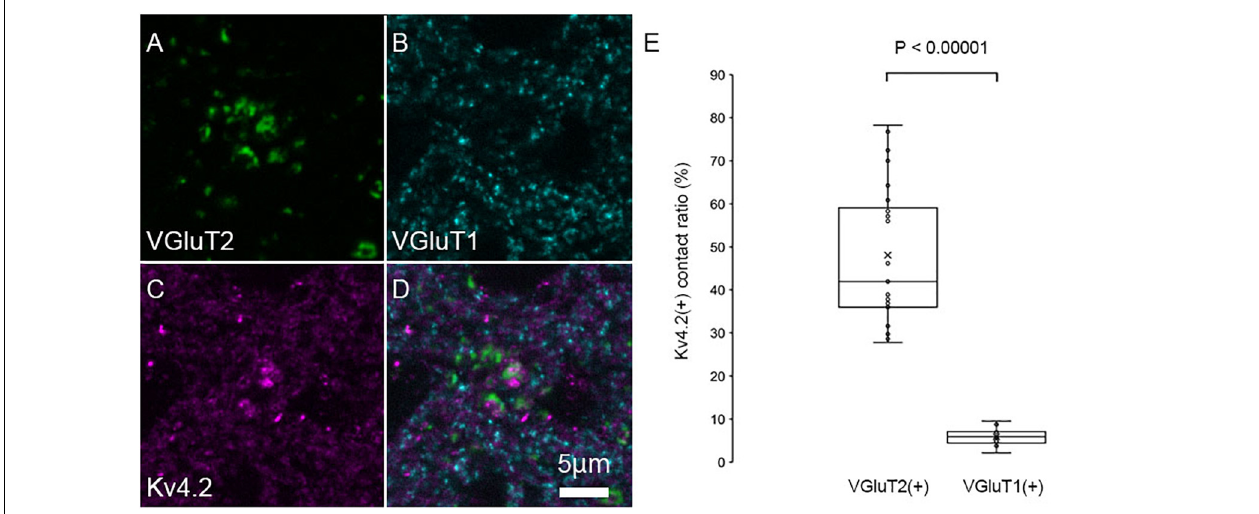
FIGURE 4 | Kv4.2 protein domains are found in preferential contact with VGluT2 and not with VGluT1. (A–D) Triple immunofluorescent labeling for vesicular glutamate transporter 2 (VGluT2, green: A ), vesicular glutamate transporter 1 (VGluT1, cyan: B ), voltage-dependent potassium channel 4.2 (Kv4.2, magenta: C ), and merged (D) as shown in images in the adult mouse MGV. Scale bar: 5 µ m. (E) The ratio of (VGluT1 or VGluT2 positive) axon terminals that are contact with Kv4.2-positive puncta in all (VGluT1 or VGluT2 positive, respectively) axon terminals is significantly higher in the VGluT2-positive excitatory axon terminals than in the VGluT1-positive terminals ( P < 0.00001, t -test). The horizontal lines in the box and whisker plots represent the median values, and the bottom and top of the boxes represent the lower and upper quartiles, respectively. The “x” represents the mean, and the bars represent the minimum and maximum values within 1.5 times the lower and upper quartiles.